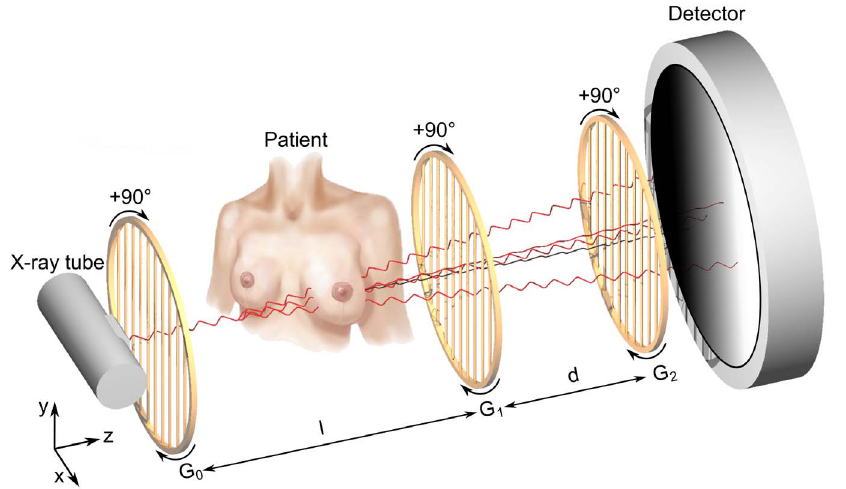
Figure 1. Schematic overview of the bi-directional phase-contrast mammography setup. The setup consists of a conventional x-ray tube, a source grating G 0 , a phase grating G 1 , an analyser grating G 2 and a flat panel detector. The two-directional, orthogonal scanning approach is indicated by a 90 u rotation of the gratings. For practical reasons the rotation of the specimen was preferred.